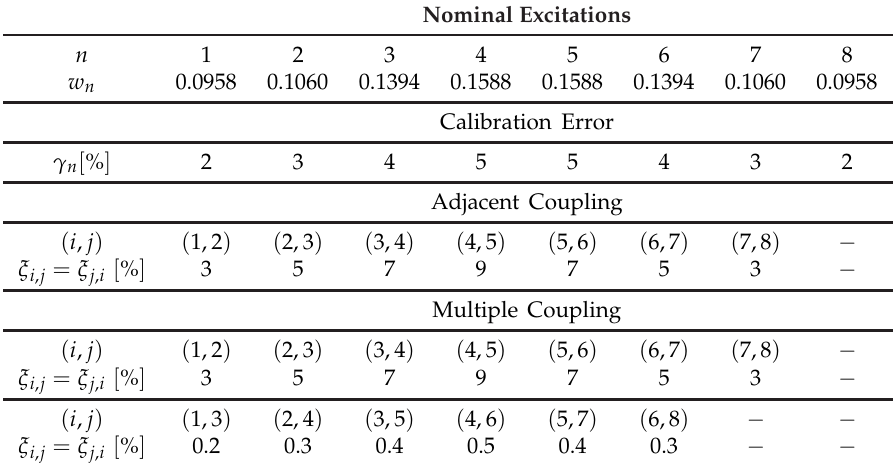
Calibration Errors, Adjacent and Multiple Mutual Coupling ( N = 8, d = λ Dolph–Chebyshev pattern: SLL ref = − 20 dB)—Nominal excitations ( w = { w n : n = 1, ..., N } ),